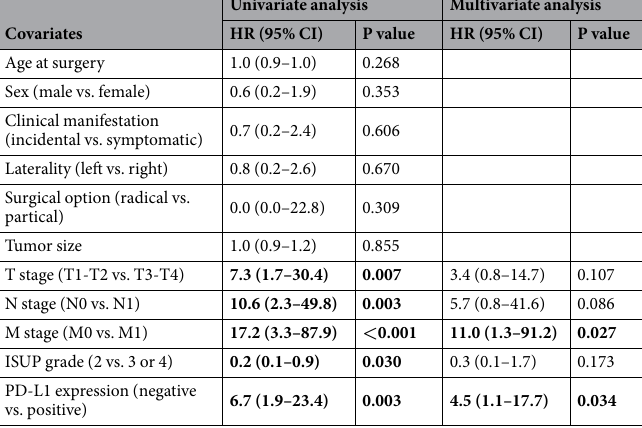
Table 3. Univariate and multivariate Cox regression analyses of OS in 36 enrolled adult Xp11.2 RCC patients. OS, overall survival; Xp11.2 RCC, Xp11.2 translocation renal cell